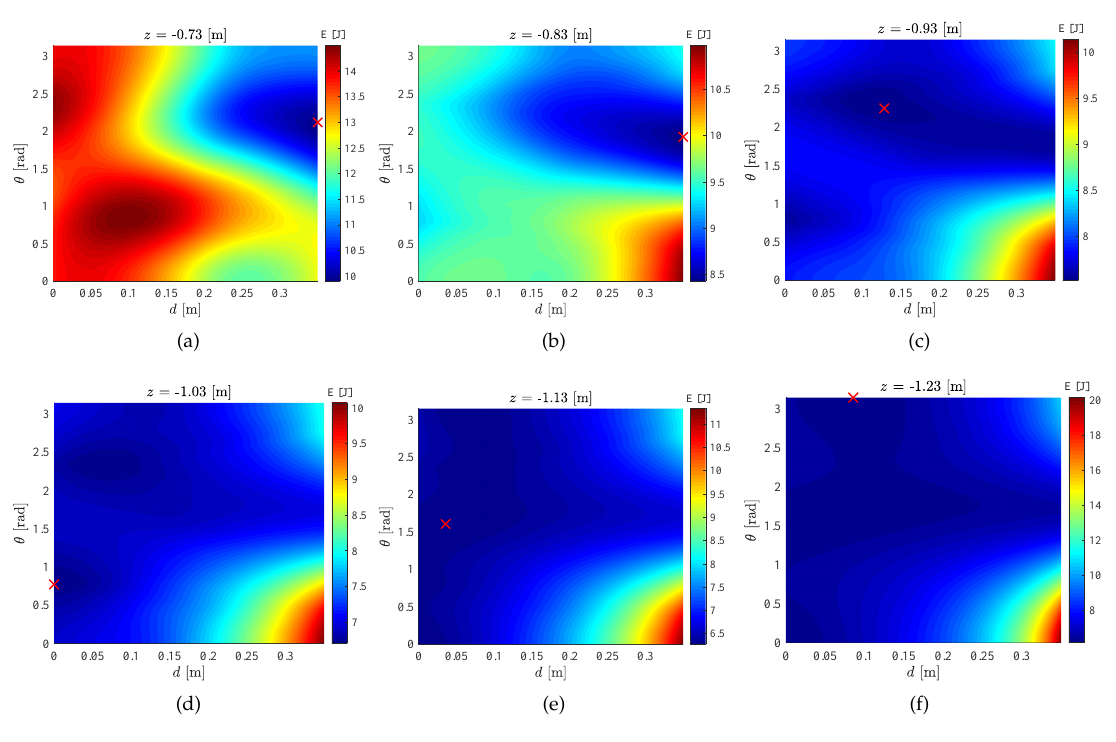
Figure 8. Energy consumption maps for Case (1).